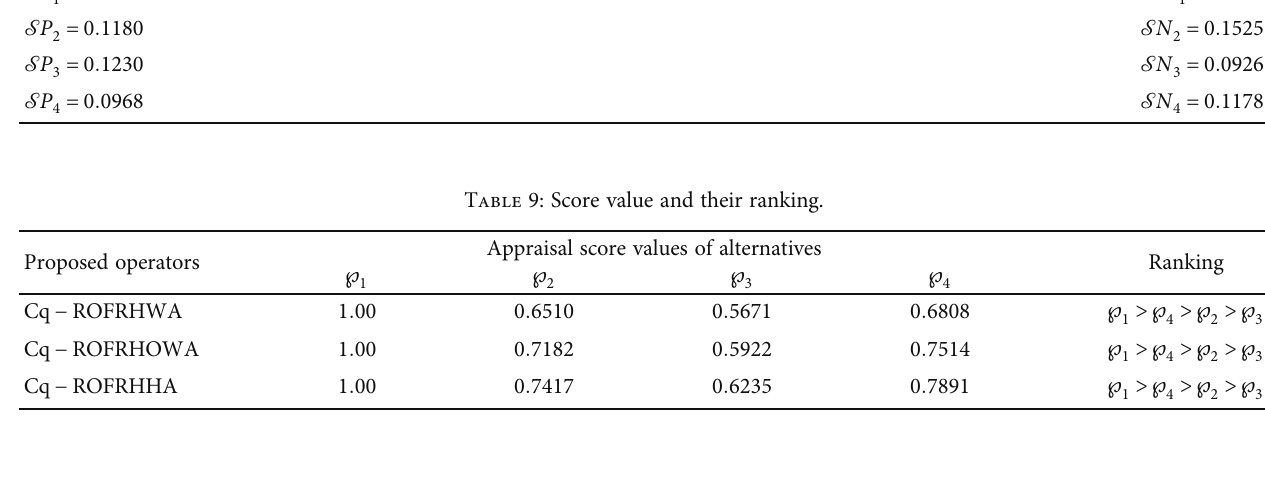
Table 8: The values of S P